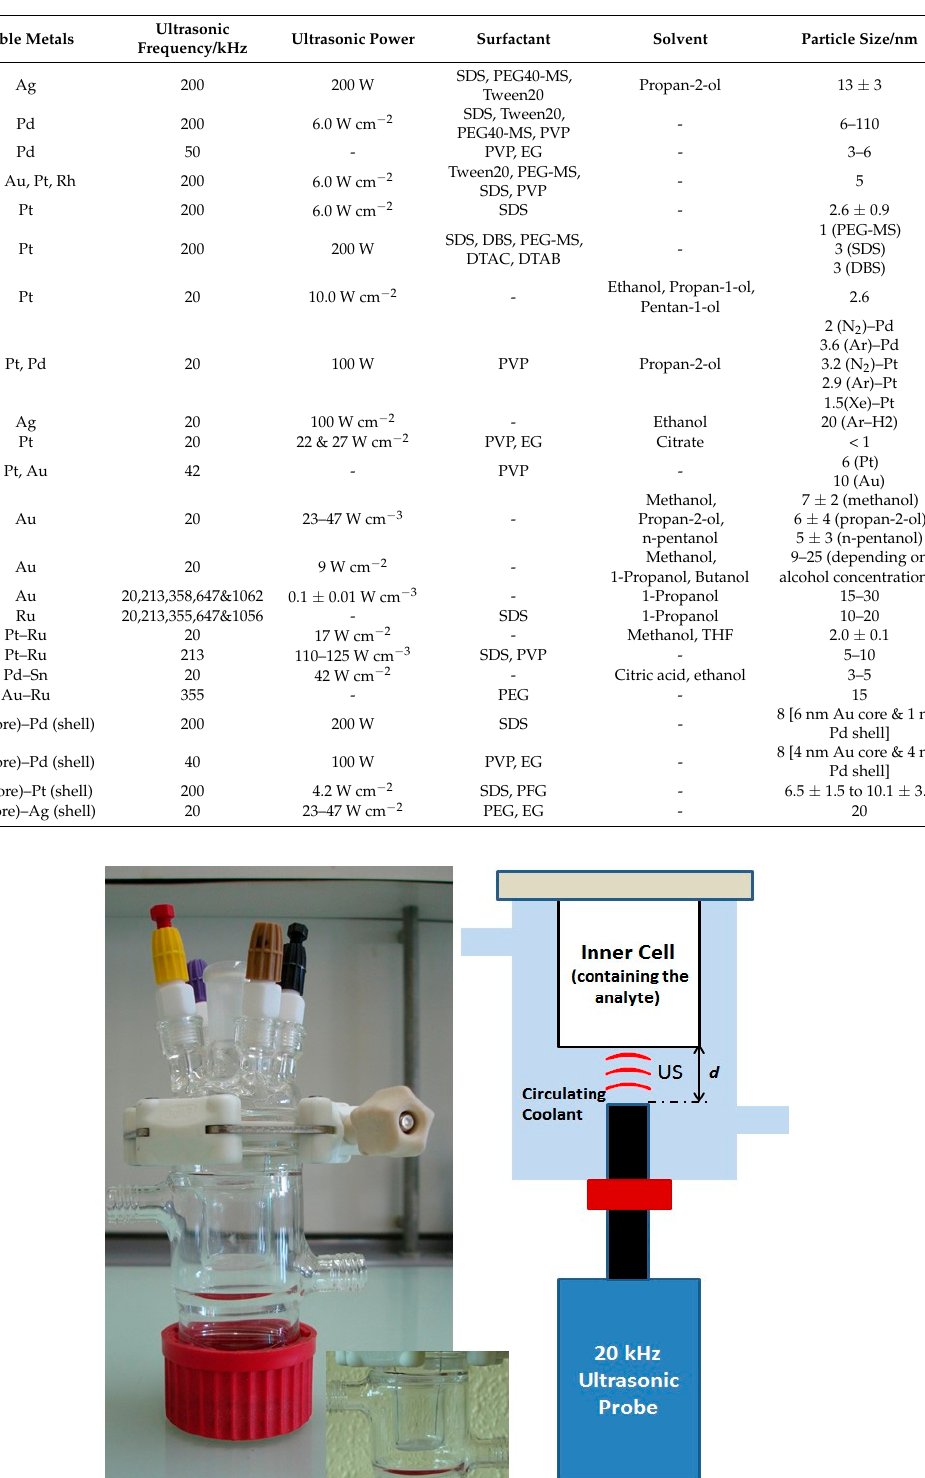
Table 1. Sonochemical production of nanosize electrocatalyst materials at several ultrasonic frequencies and powers in the presence of several alcohols and surfactants (adapted from [15]).